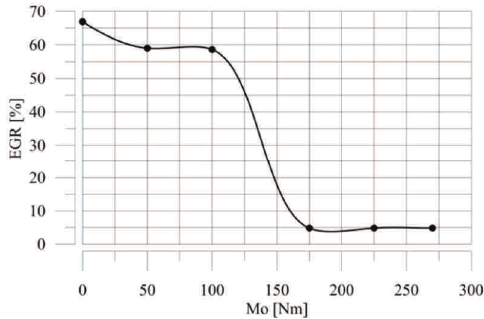
Fig. 1. Influence of engine load on factory change of opening of exhaust gas recirculation valve (EGR)